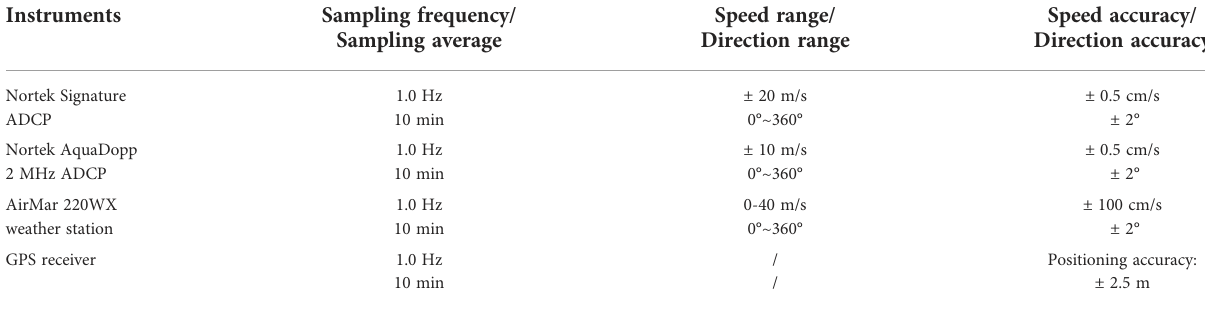
TABLE 2 Performance parameters of the experimental